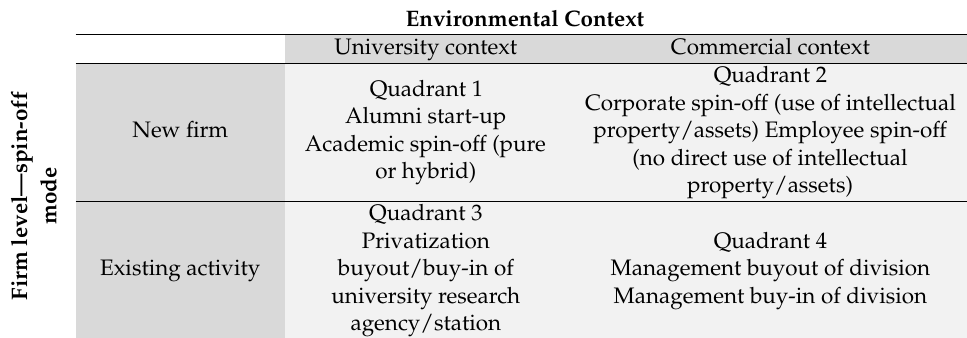
Table 4. A typology of spin-offs in different quadrants adapted from Fryges and Wright (2014). Environmental Context University context Commercial context Quadrant 2 Quadrant 1 Corporate spin-off (use of intellectual Alumni start-up property/assets) Employee spin-off New firm Academic spin-off (pure (no direct use of intellectual or hybrid) property/assets) Quadrant 3 Privatization Quadrant 4 Existing activity buyout/buy-in of Management buyout of division Management buy-in of university research agency/station